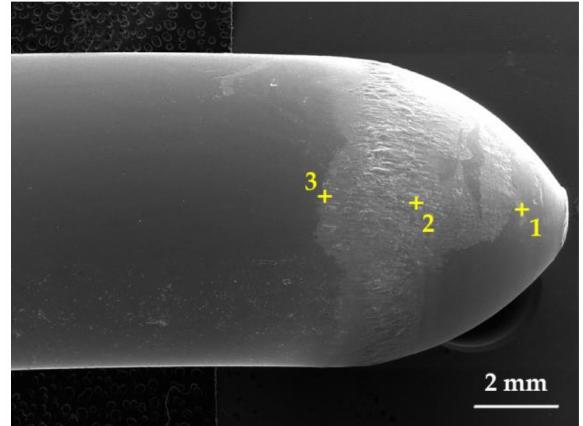
Figure 9. The punch surface after 120,000 strokes.